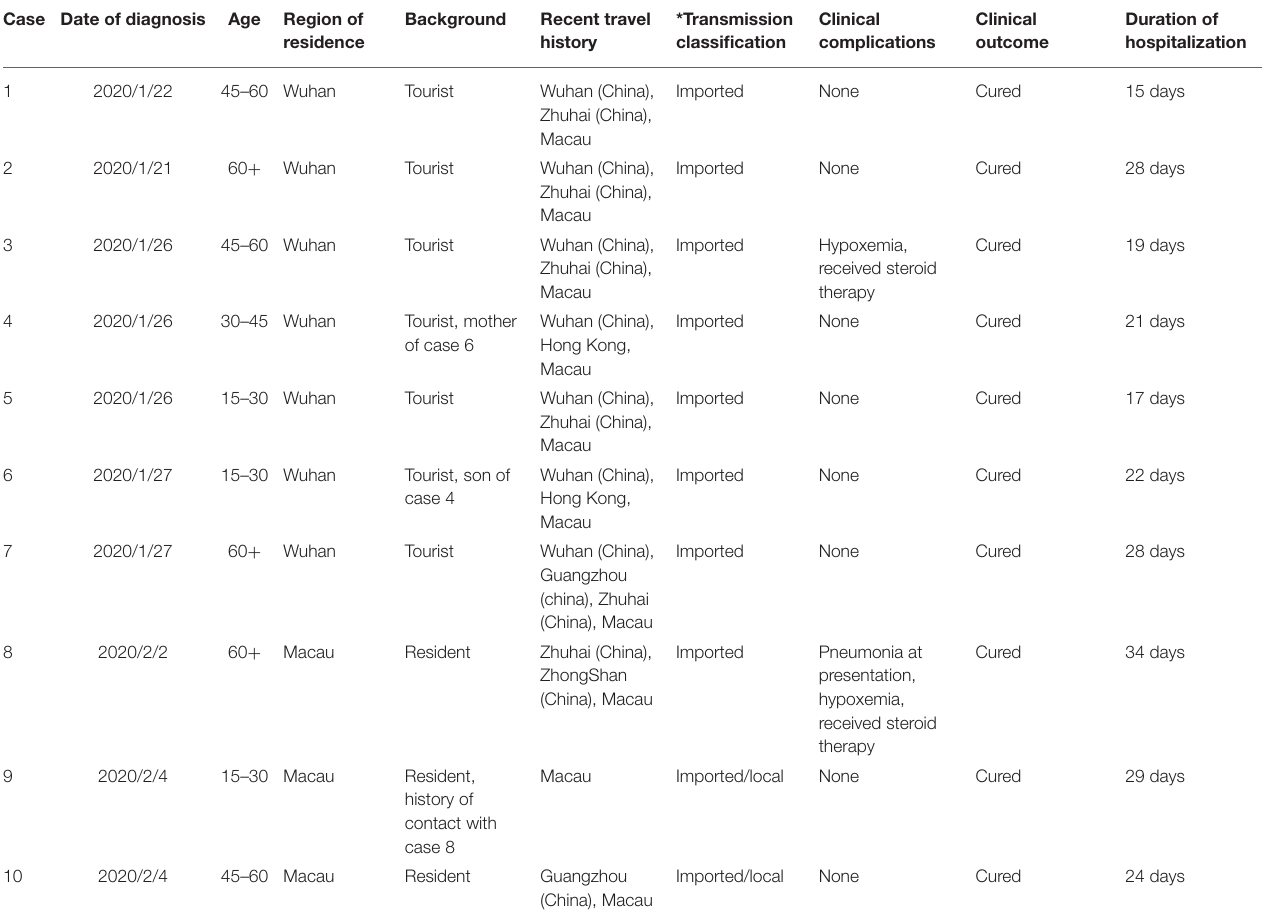
TABLE 1 | Demographics and clinical course of the first 10 confirmed cases in